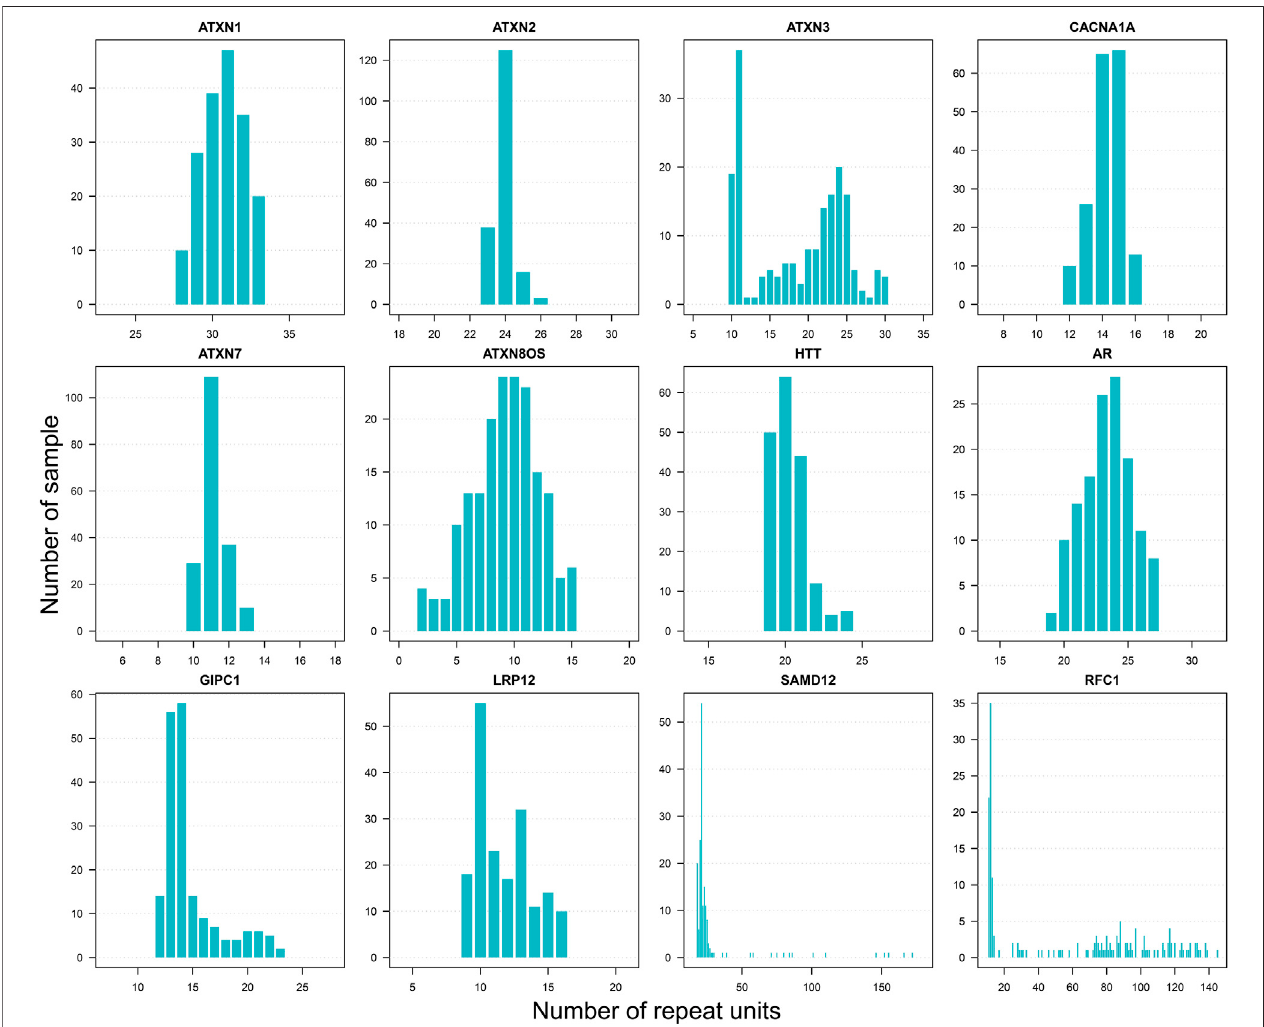
FIGURE 2 | Distribution of repeat sizes for disease-associated STR loci. Selected well-studied disease-associated STR loci. Repeat unit CAG includes ATXN1 (Spinocerebellar Ataxia Type 1), ATXN2 (Spinocerebellar Ataxia Type 2), ATXN3 (Spinocerebellar Ataxia Type 3), CACNA1A (Spinocerebellar Ataxia Type 6), ATXN7 (Spinocerebellar Ataxia Type7), ATXN8OS(Spinocerebellar Ataxia Type8), HTT(Huntington ’ sdisease), andAR(Spinaland Bulbar Muscular Atrophy).Repeat unitCCG includes GIPC1 (oculopharyngodistal myopathy) and LRP12 (oculopharyngodistal myopathy). Repeat unit TAAAA includes SAMD12 (familial cortical myoclonic tremor with epilepsy). Repeat unit AAAAG includes RFC1 (cerebellar ataxia, neuropathy, and vestibular are fl exia